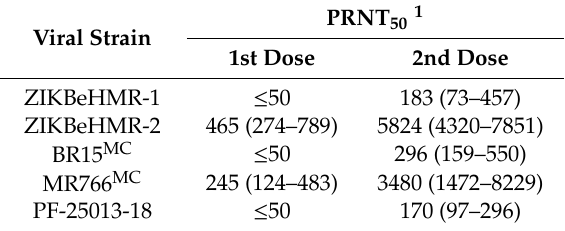
Table 2. Neutralizing activity of anti- ZIKBeHMR-2 antibody against various ZIKV strains. Viral Strain